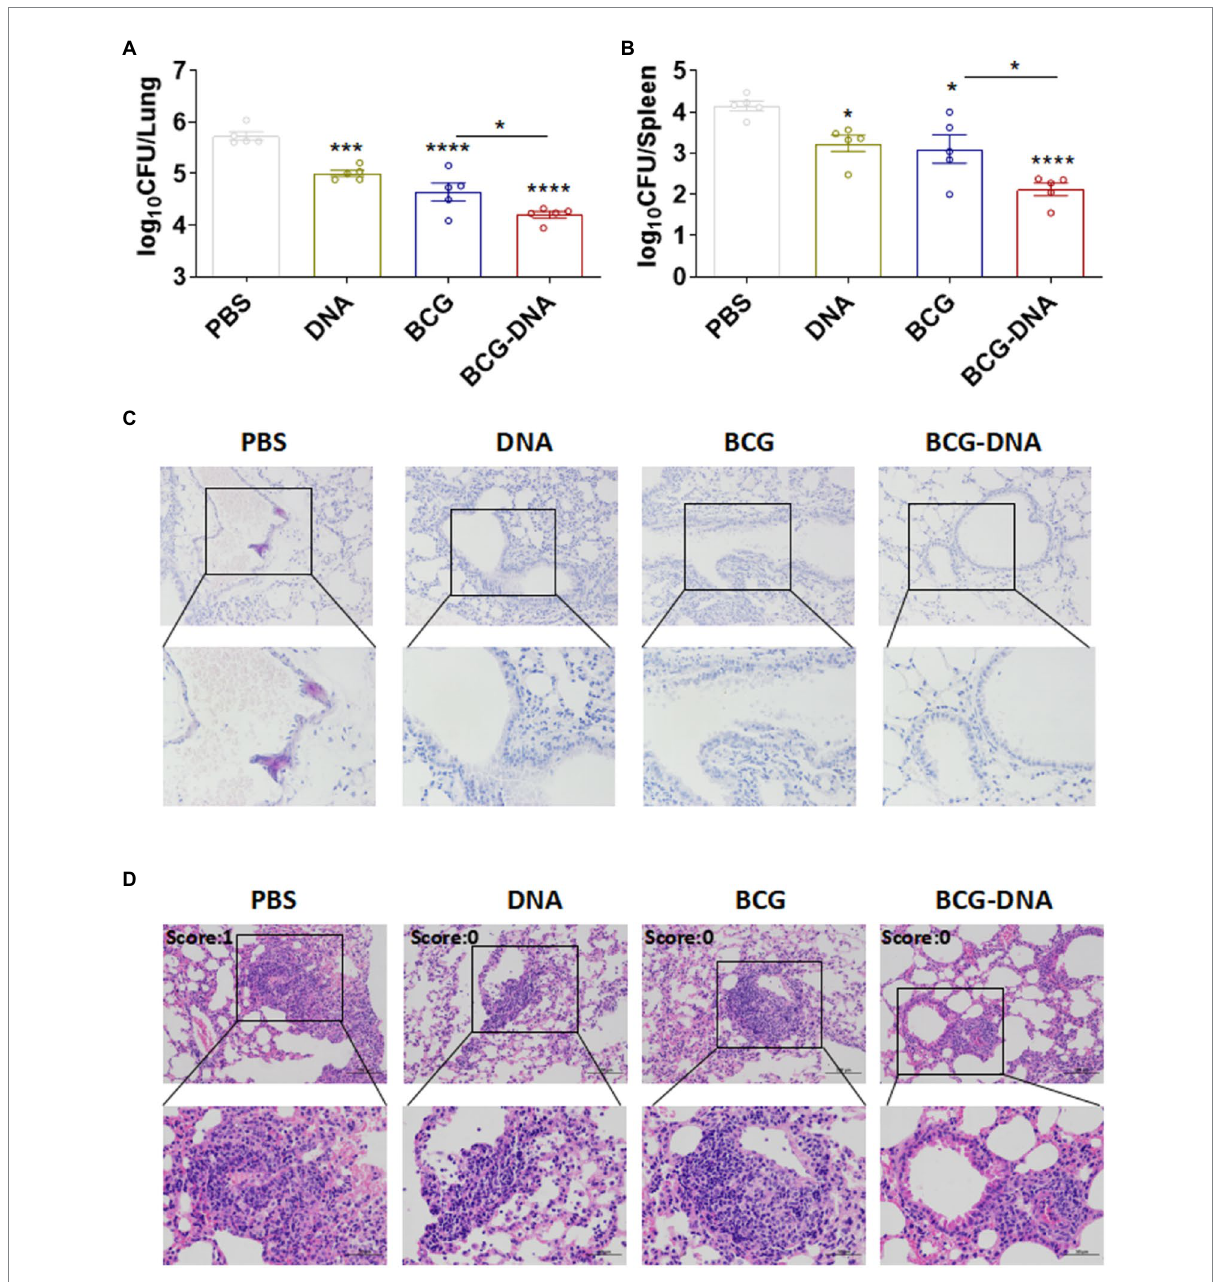
FIGURE 5 Enhanced protection by the BCG prime-DNA boost regimen. Six weeks after the primary immunization, mice ( n = 5) were aerosol-challenged with Mtb H37Rv then sacrificed at four weeks post-infection. Bacterial loads in the lungs (A) and spleens (B) are shown as the mean log 10 CFU/ organ ± SEM. (C) The histopathology of lung tissues assessed in sections stained by acid-fast staining. Scale bars; 100 μ m (top: original magnification ×200) and 50 μ m (bottom: original magnification ×400). (D) H&E staining of the lungs of infected mice at four weeks post- infection ( n = 5 mice, one-way ANOVA, mean ± SEM). * p < 0.05, ** p < 0.01, *** p < 0.001, **** p < 0.0001: a significant difference of treatment groups from the appropriate controls (PBS group). ns , no significant